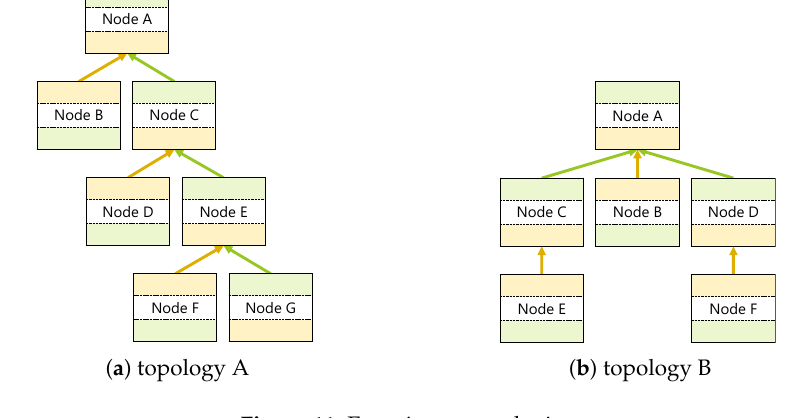
Figure 11. Experiment